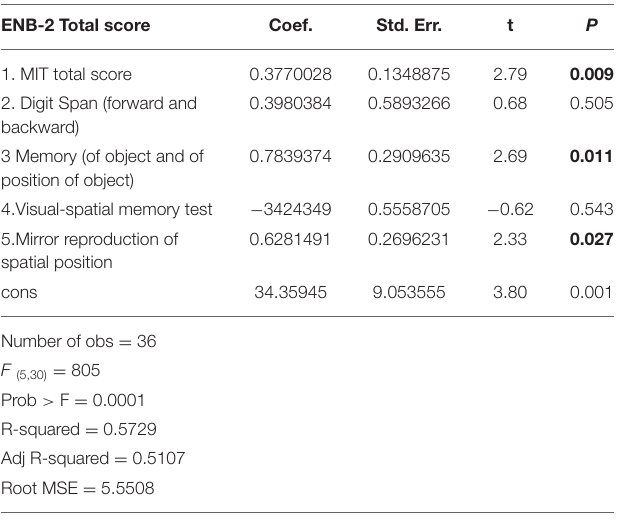
TABLE 6 | Multiple linear regression between ENB-2 and MIT with comparison tasks. ENB-2 Total score